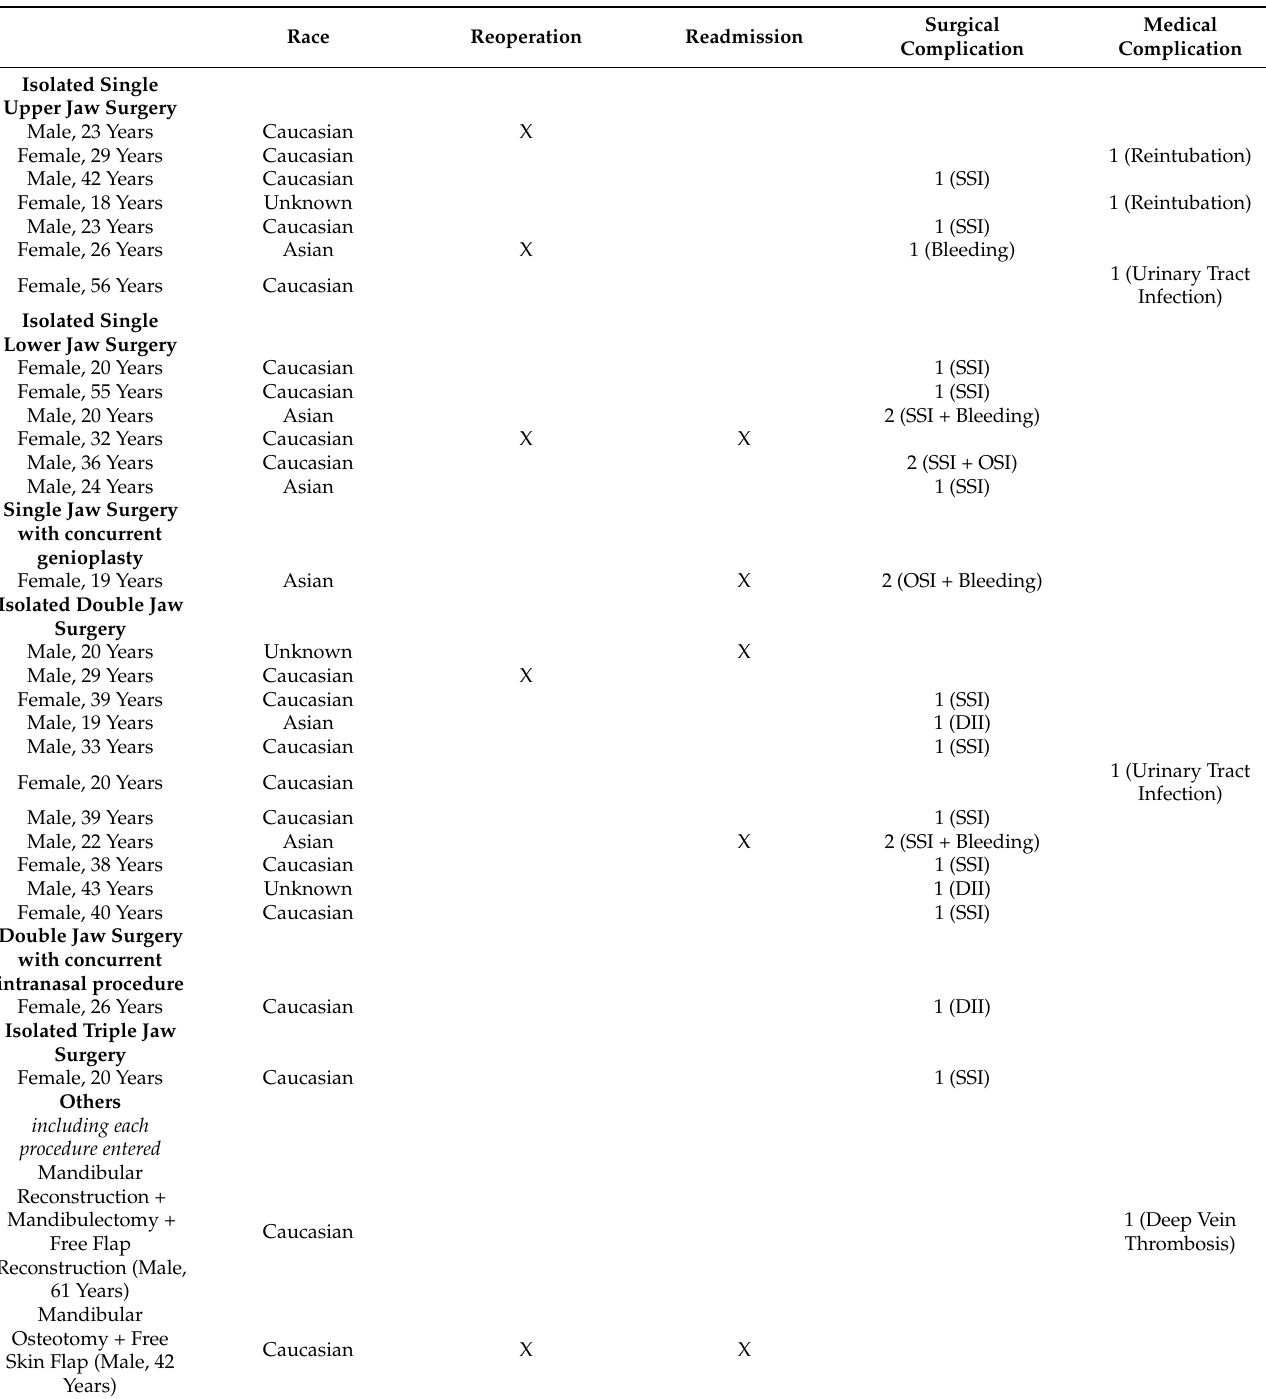
Table 6. Detailed information on all cases with complications. Adverse events occurred in 29 cases (4.3%). All readmissions were